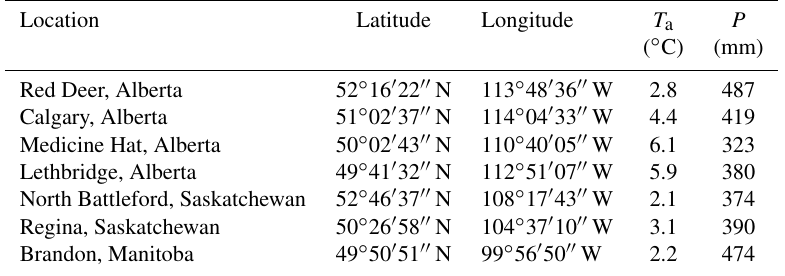
Table 2. Climate characteristics (1981–2010 climate normal) of the seven selected locations located in and near the High Elevation Grassland class. T a is mean annual temperature, and P denotes mean annual